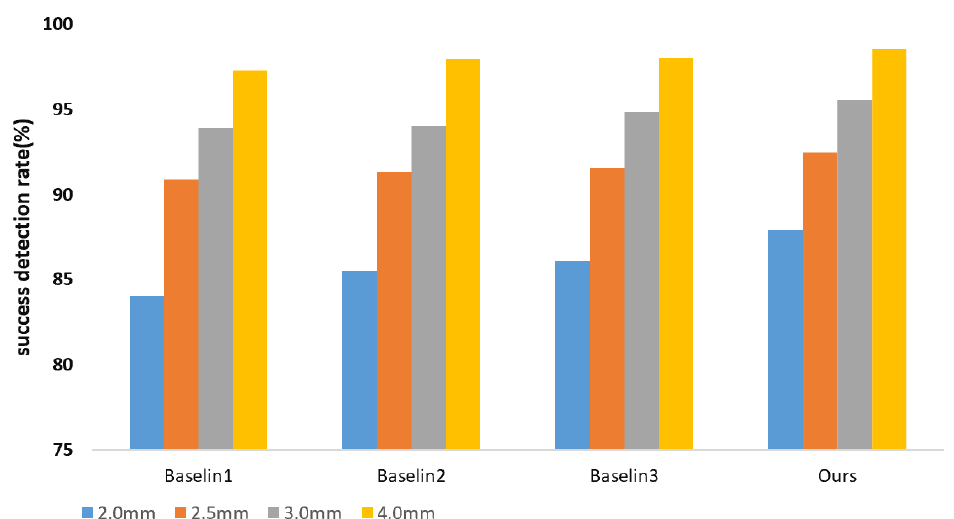
Figure 5. Ablation study of our model. Success detection rates (SDRs) using four precision ranges, including 2 mm, 2.5 mm, 3 mm, and 4 mm, with 150 test images.